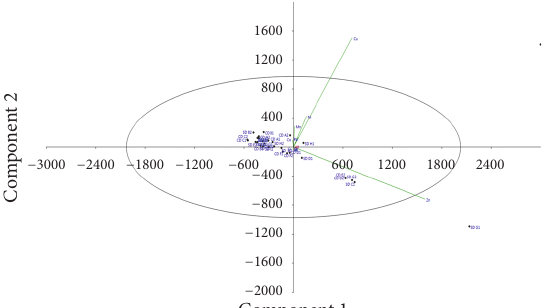
Figure 9: Cluster analysis showing the possible common source for most of the trace metals in some of the